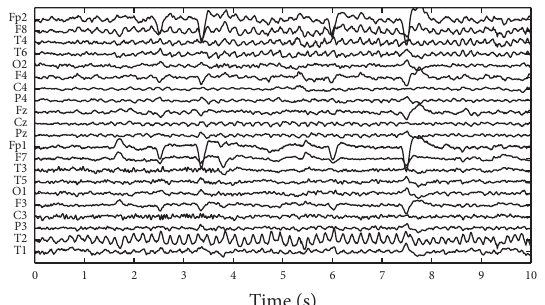
Figure 9: Reconstructed ictal EEG signals after muscle artifact